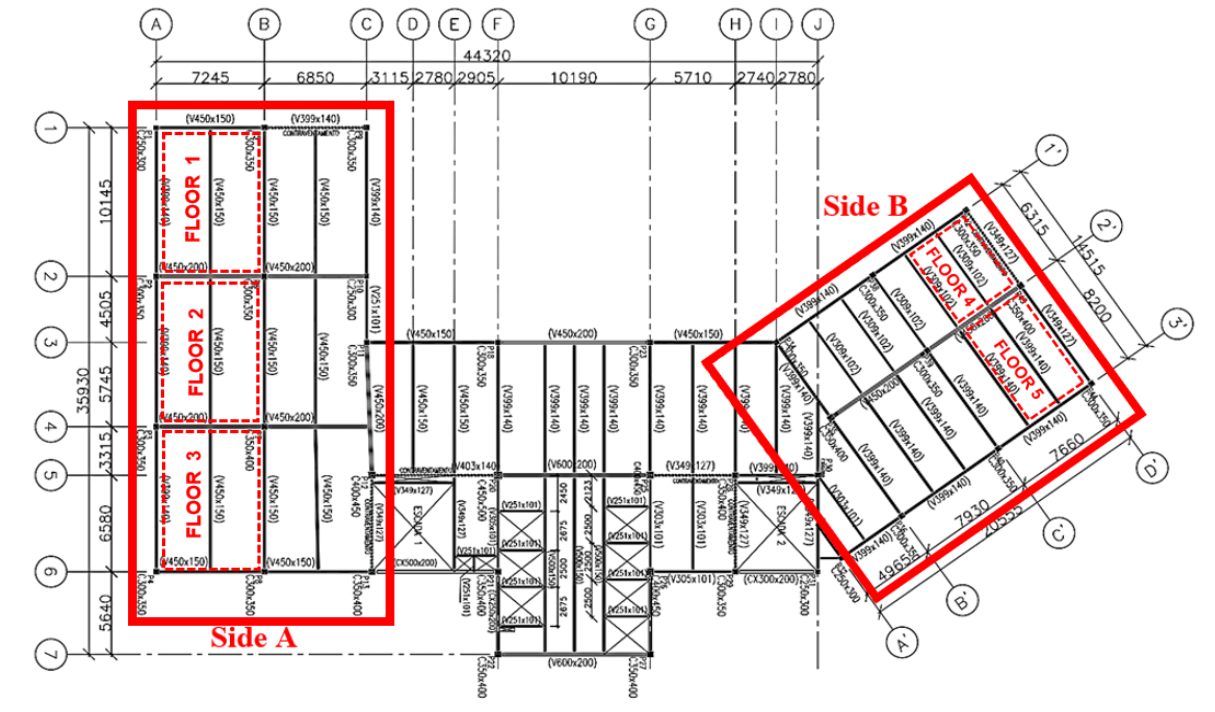
Figure 1. Composite floor (steel-concrete) investigated: 8 th floor